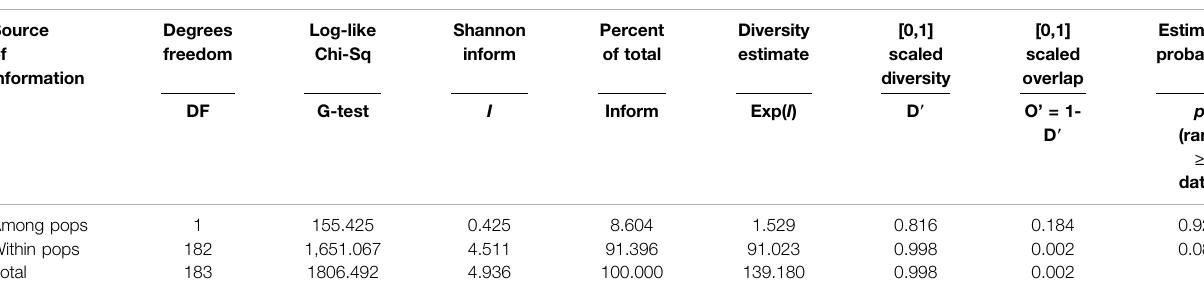
TABLE 3 | Population Shannon information index ( I ). Source of